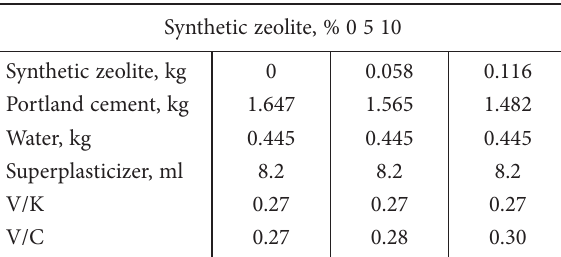
Table 1. Compositions of hardened cement paste, 1m³